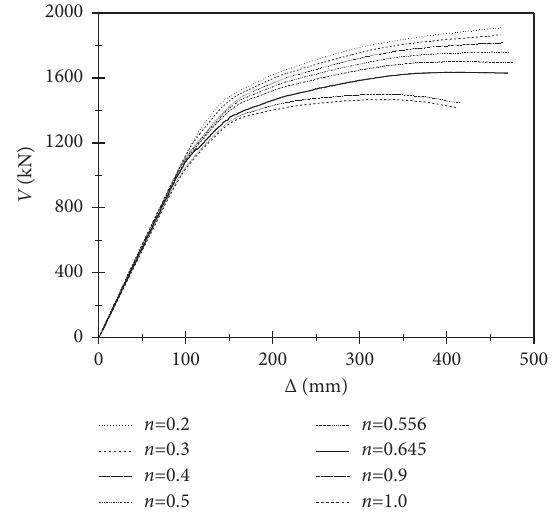
Figure 10: Capacity curves of structures with different